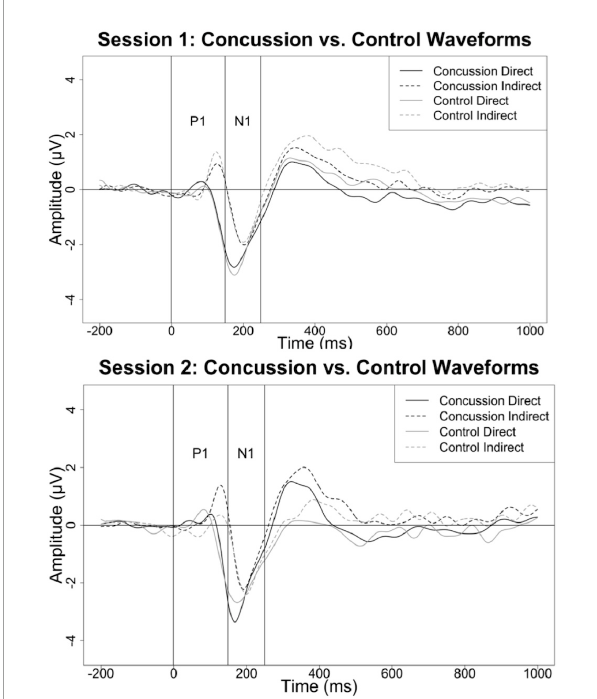
FIGURE2 Event-related potential (ERP) waveforms for the direct and indirect P1 and N1 components by concussion and control group for session 1 [ (top) ; within 3 weeks of concussion] and session 2 [ (bottom) ; approximately 10 months after injury].